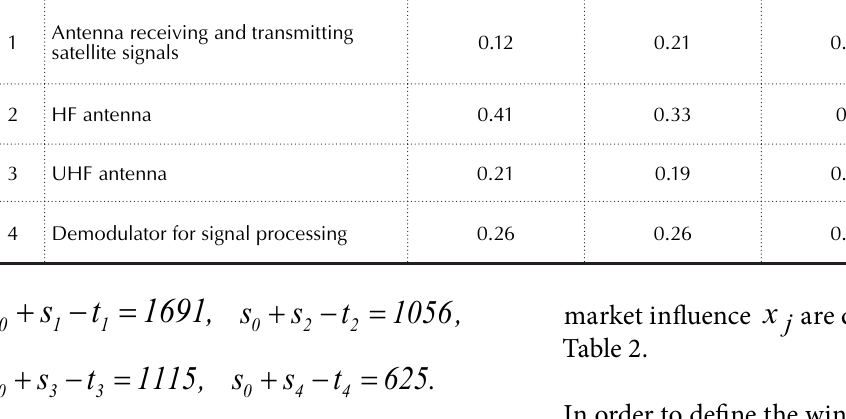
Table 2. Calculated optimal strategies of improved product manufacturing